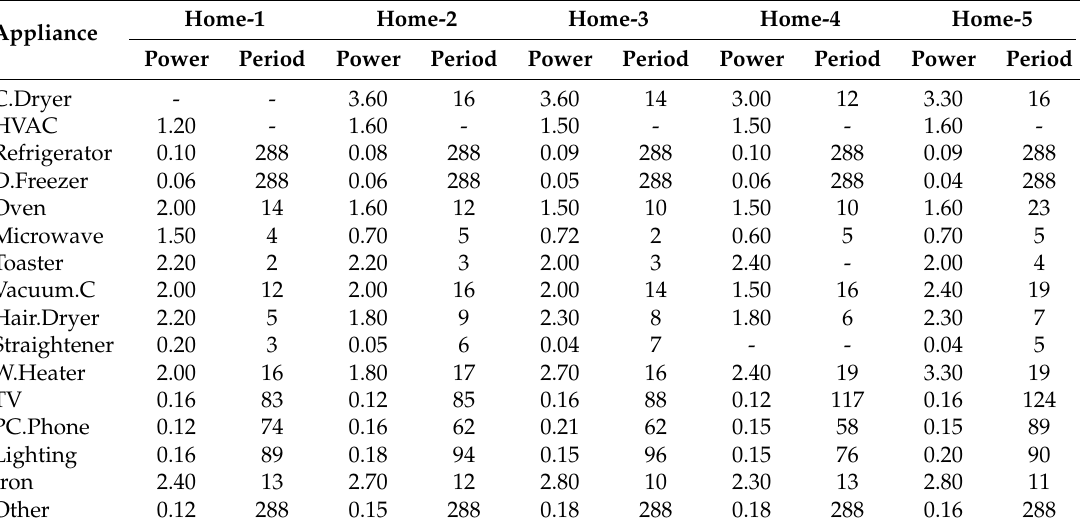
Table 1. Appliances operation parameters.